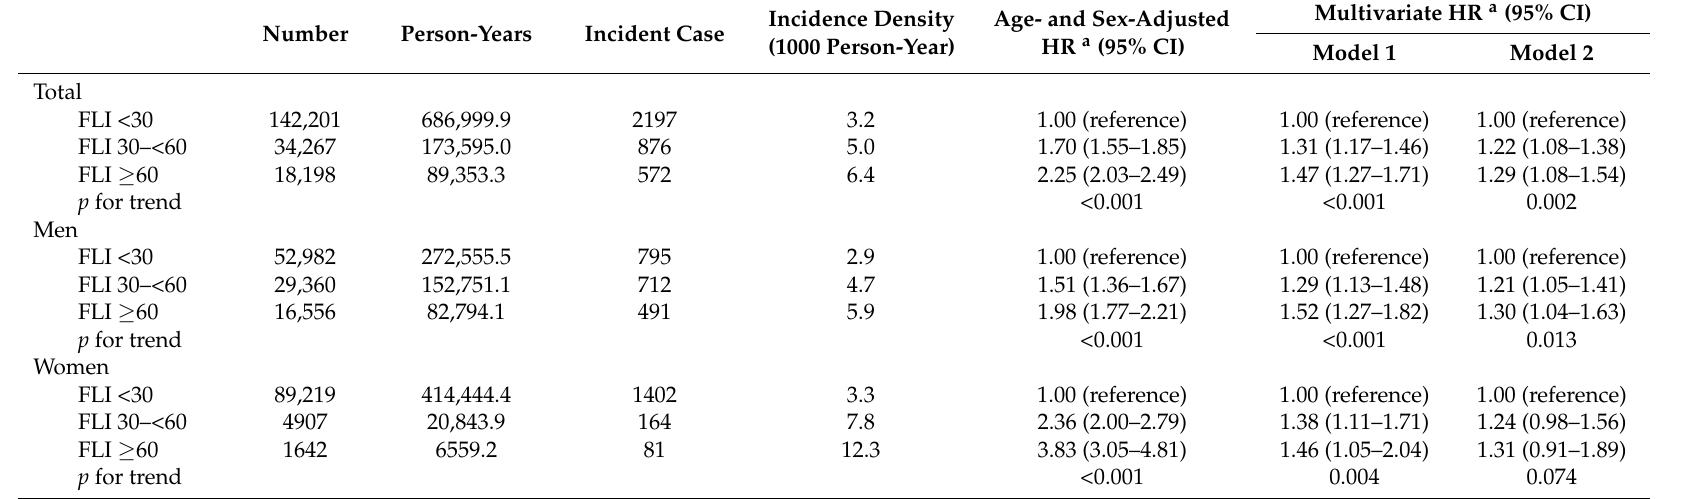
Table A2. The associations between fatty liver index (FLI) and the development of gallstones ( n =